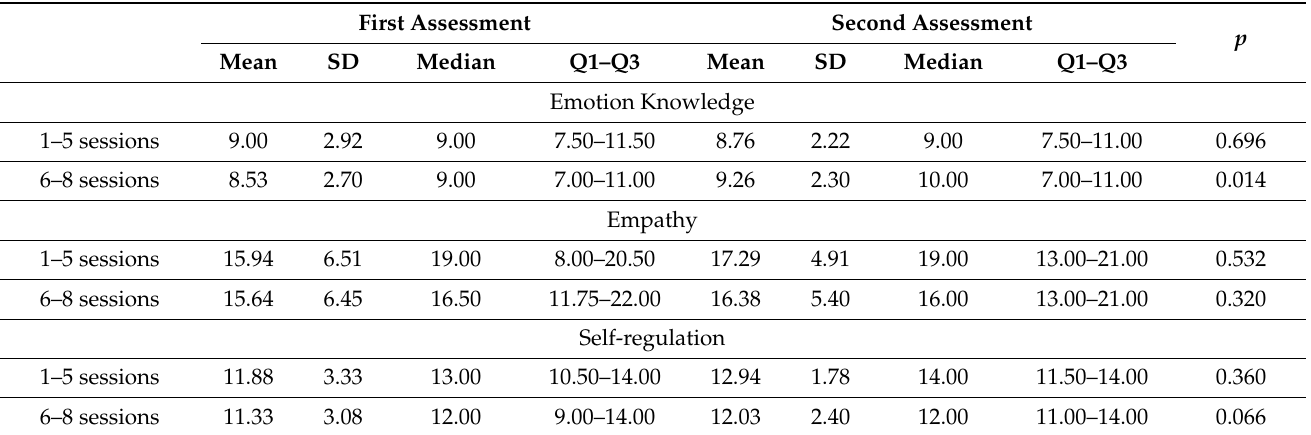
Table 9. Changes in the EMK screening between the data of the first and second assessments in the experimental group according to the number of sessions attended.